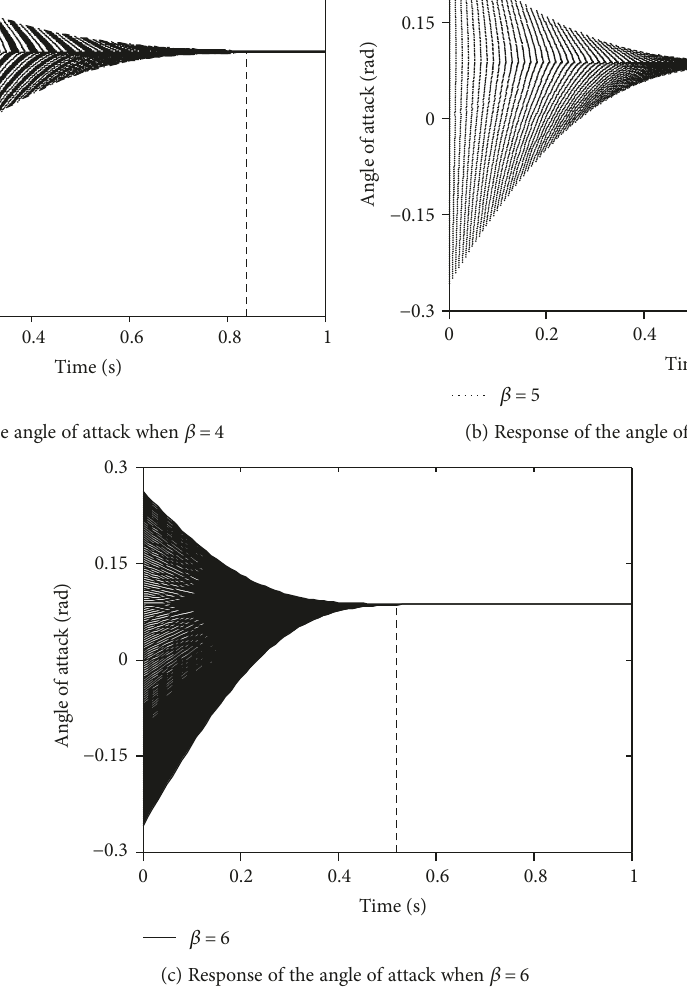
Figure 3: System response with the designed